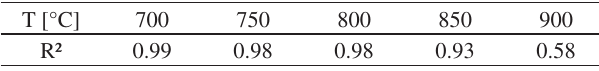
Table 3. Correlation factor (R²) between experimental and calculated sigma phase content for the studied